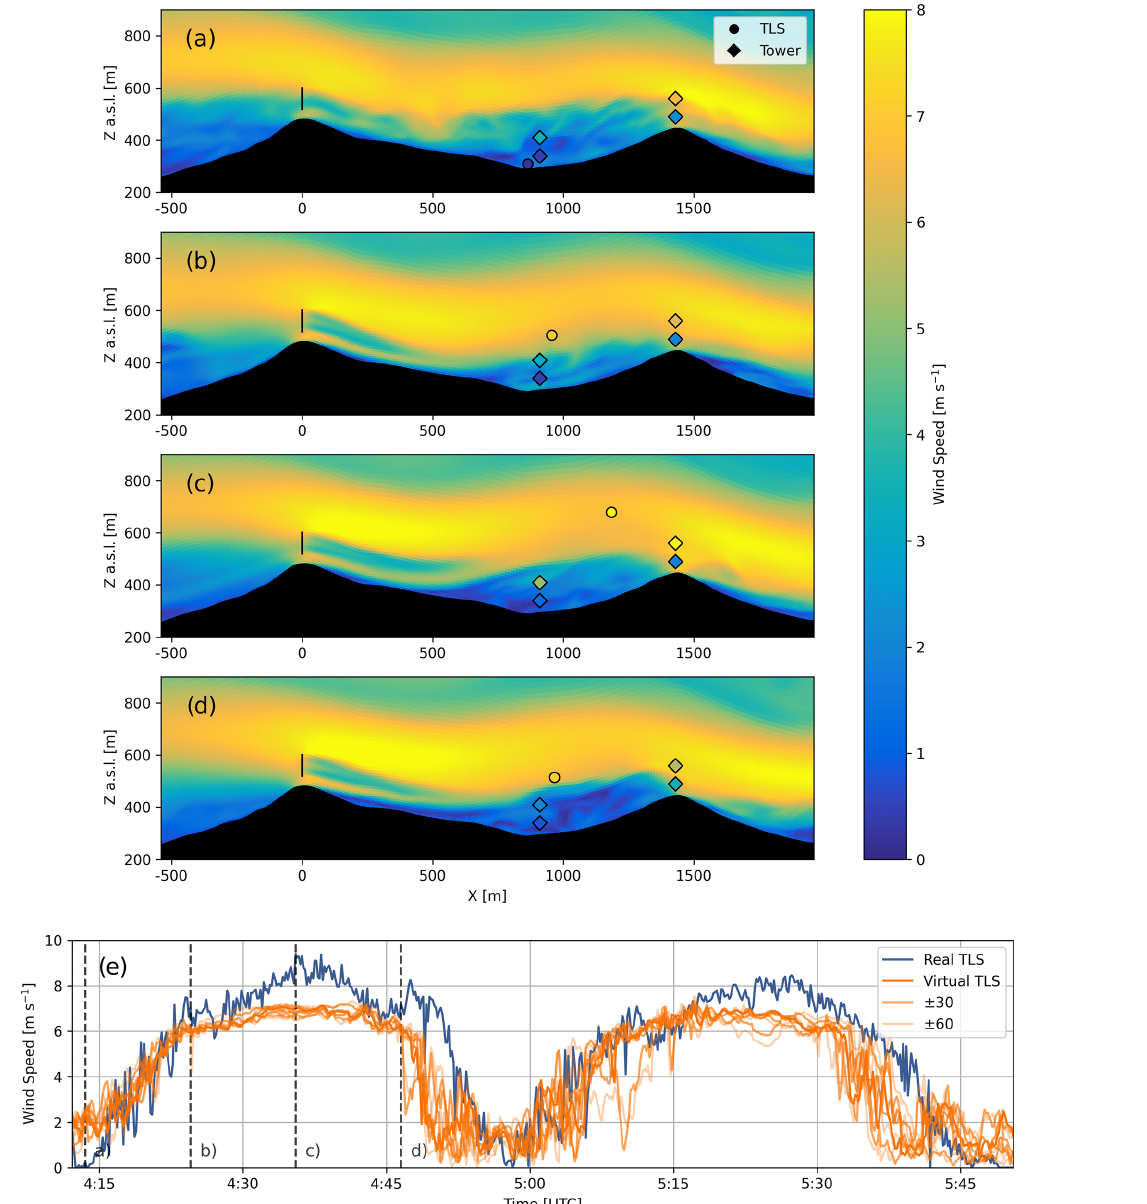
Figure 6. Transects of instantaneous wind speed for WRF with measurements from V_TSE09, NE_TSE13, and the TLS overlaid for (a) 04:13:30UTC, (b) 04:24:30UTC, (c) 04:35:30UTC, and (d) 04:46:30UTC and (e) comparison of wind speed between the TLS data and the virtual TLS in WRF–LES–GAD d05. The transects are aligned with the wake transect in Fig. 1. Virtual TLSs with an easting and northing position ± 30 and ± 60m are shown with a lighter shading, and dashed lines indicate the times shown in the transects. An animation of model results for when the TLS is operational is included in the supplementary material (see Video 2 in the Video